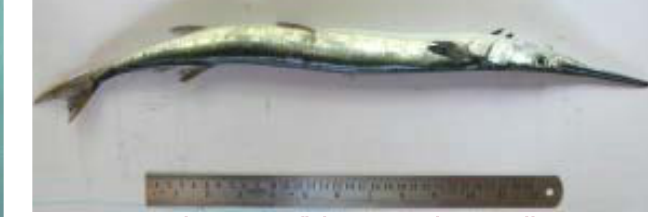
Image 18. Freshwater Garfish Xenentodon cancila